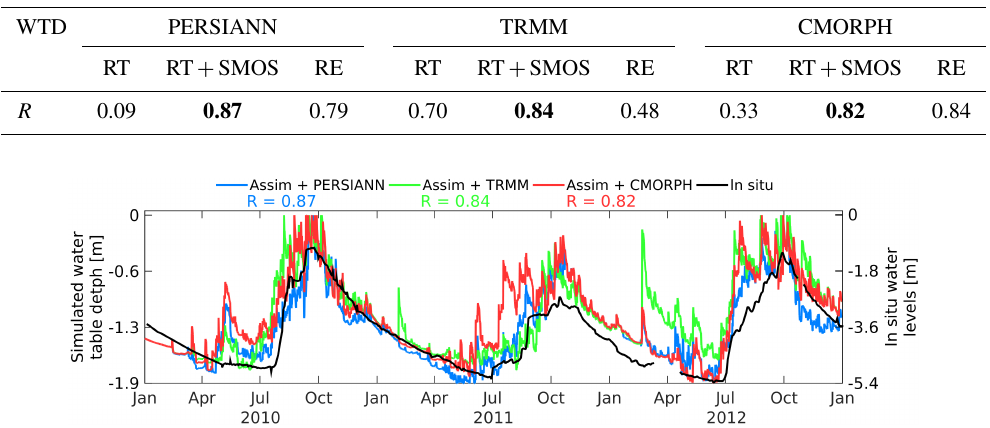
Figure 7. Simulations of the water table depth at the Nalohou station (in situ measurements in black) using RT precipitation for after SMOS assimilation (in colors). Correlations are also indicated in the